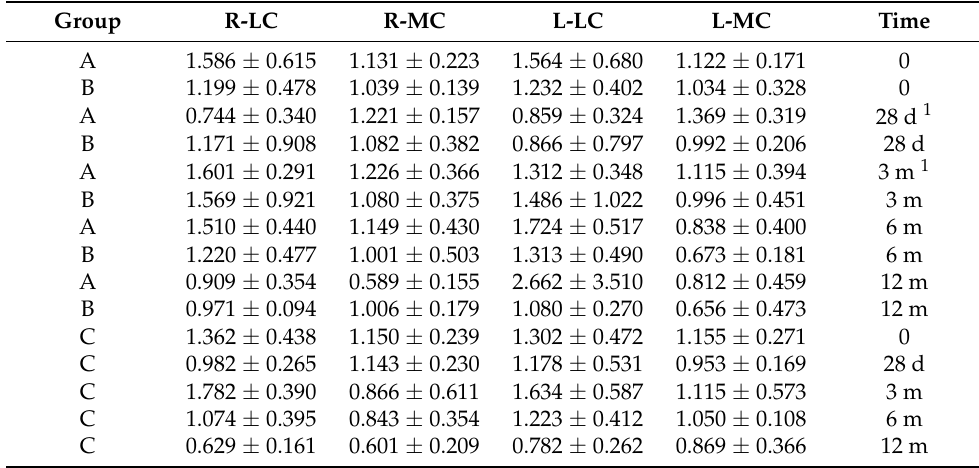
Table 1. Descriptive statistics of the radiological study for male rabbits.